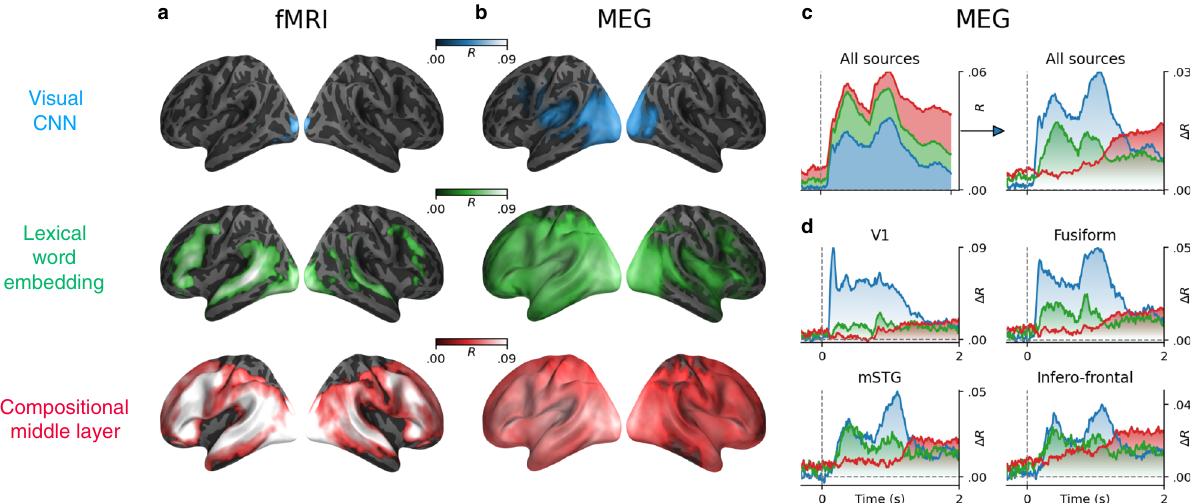
Fig. 3 Brain-score comparison across embeddings. Lexical and compositional representations (see Supplementary Note 4 for the de fi nition of compositionality) can be isolated from (i) the word embedding layer (green) and (ii) one middle layer (red) of a typical language transformer (here, the ninth layer of a 12-layer causal transformer), respectively. We also report the brain scores of a convolutional neural network trained on visual character recognition (blue) to account for low-level visual representations. a Mean (across subjects) fMRI scores obtained with the visual, word, and compositional embeddings. All colored regions display signi fi cant fMRI scores across subjects ( n = 100) after false discovery rate (FDR) correction. b Mean MEG scores averaged across all time samples and subjects ( n = 95 subjects). c Left: mean MEG scores averaged across all sensors. Right: mean MEG gains averaged across all sensors: i.e., the gain in MEG score of one level relative to the level below (blue: R [visual]; green: R [word] − R [visual]; red: R [compositional] − R [word]). d Mean MEG gains in four regions of interest. For a whole-brain depiction of the MEG gains, see Supplementary Movie 2. For the raw scores (without subtraction), see Supplementary Fig. 6. For the distribution of scores across channels and voxels, see Supplementary Fig.